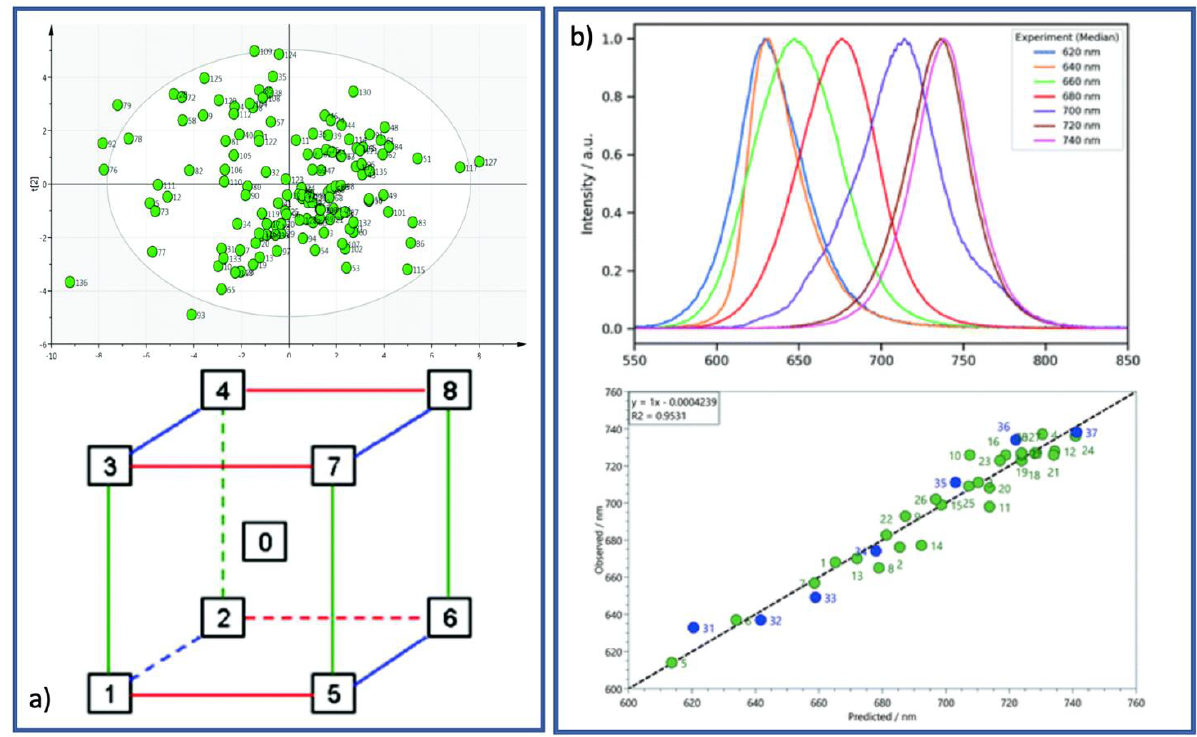
Figure 3. ( a ) The PCA solvent map (top panel) and the cuboid representing the solvent space (bottom panel) (reproduced from Ref. [57] with permission from the Royal Society of Chemistry). ( b ) The perovskite photoluminescence model validation experiment described in the text, where both S1-normalised PL emission (top panel) and observed vs. predicted wavelength PL, showing design experiments in green and validation experiments in blue (bottom panel), are presented (reproduced from Ref. [58] with permission from the Royal Society of Chemistry).